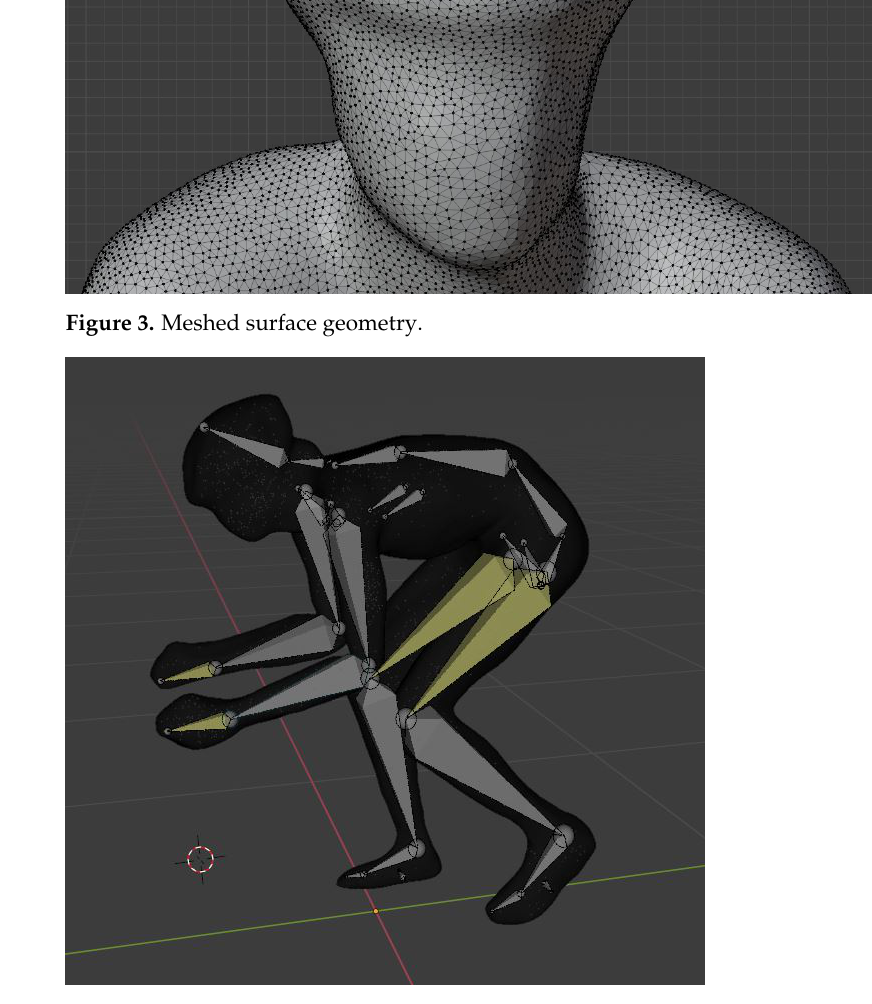
Figure 4. Position DB modelled with meta-rig (Assembly of bone chains—a feature of software